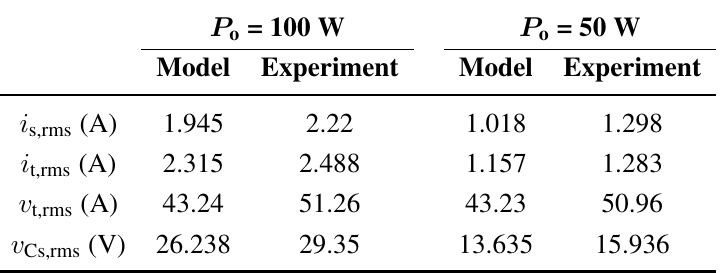
Table 2. Comparison of key parameters between experimental results and the proposed model.